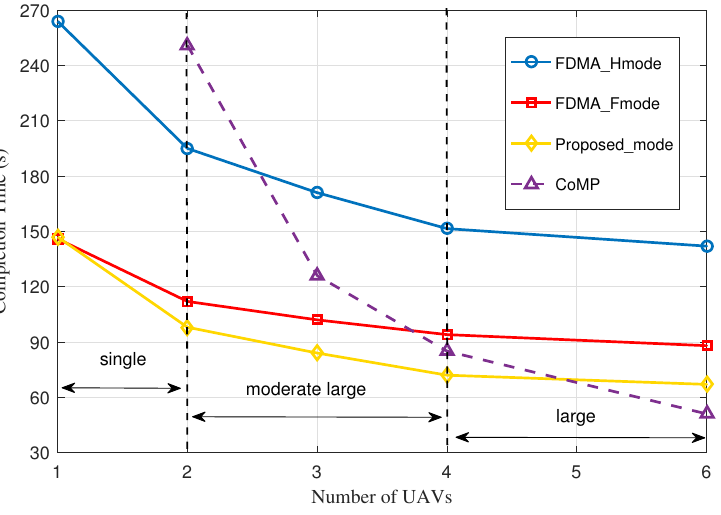
Figure 11. The completion time versus the number of UAVs under different